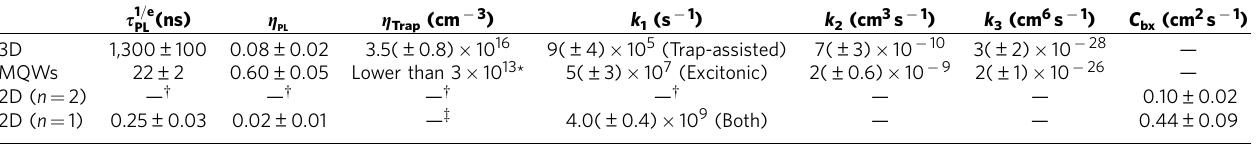
Table 1 | The PL decay effective lifetime ( s 1 = e ) and quantum yield ( g PL ) at injected carrier density of around 10 15 cm (cid:2) 3 , Trap PL states density ( g Trap ), First order ( k 1 ), Second order ( k 2 ), and Third order (three-particle Auger) recombination constant ( k 3 ), Biexciton Auger recombination coefficient ( C bx